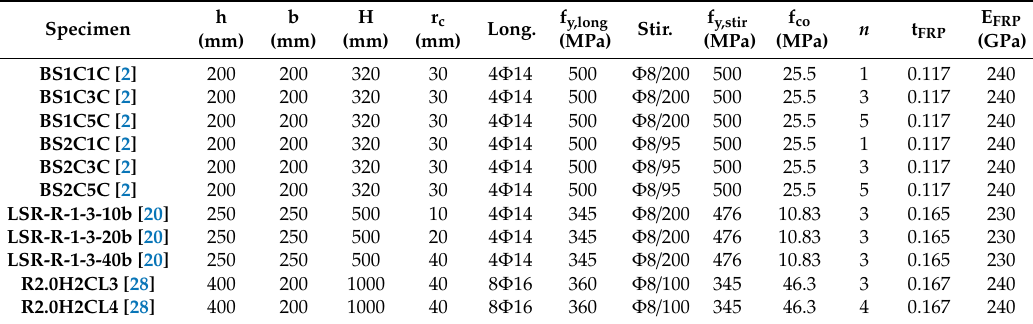
Figure 1. Axial stress-strain curves of unconfined concrete and FRP-confined concretes with ascending and descending second branches. Table 1. Geometrical and nominal mechanical data for the analyzed columns.